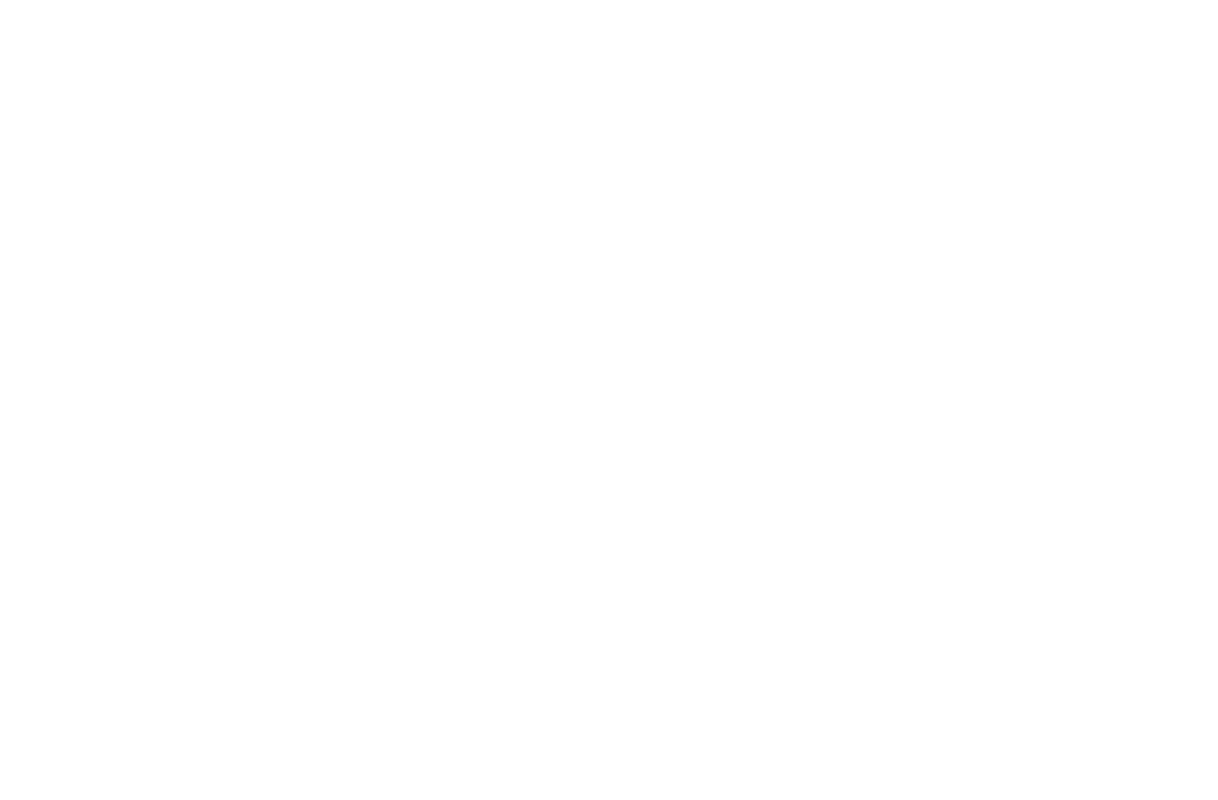
Figure 11. Axle box vertical vibration acceleration, (a-b) orbit free spectrum, (c-d) orbital